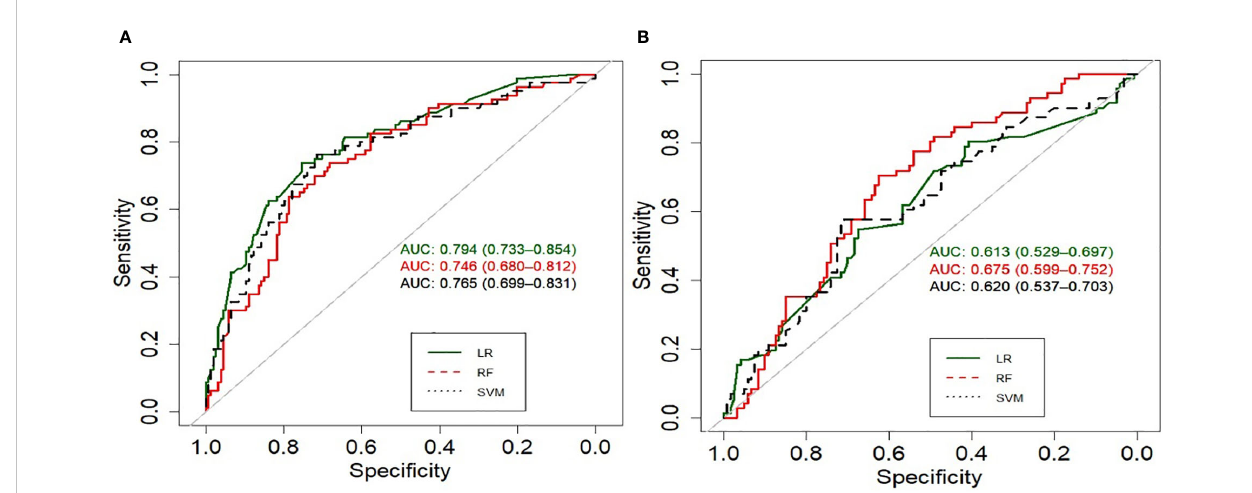
FIGURE 3 Receiver operating characteristic curves (ROC) of the models predicting UI at (A) fi rst year, (B) second year.